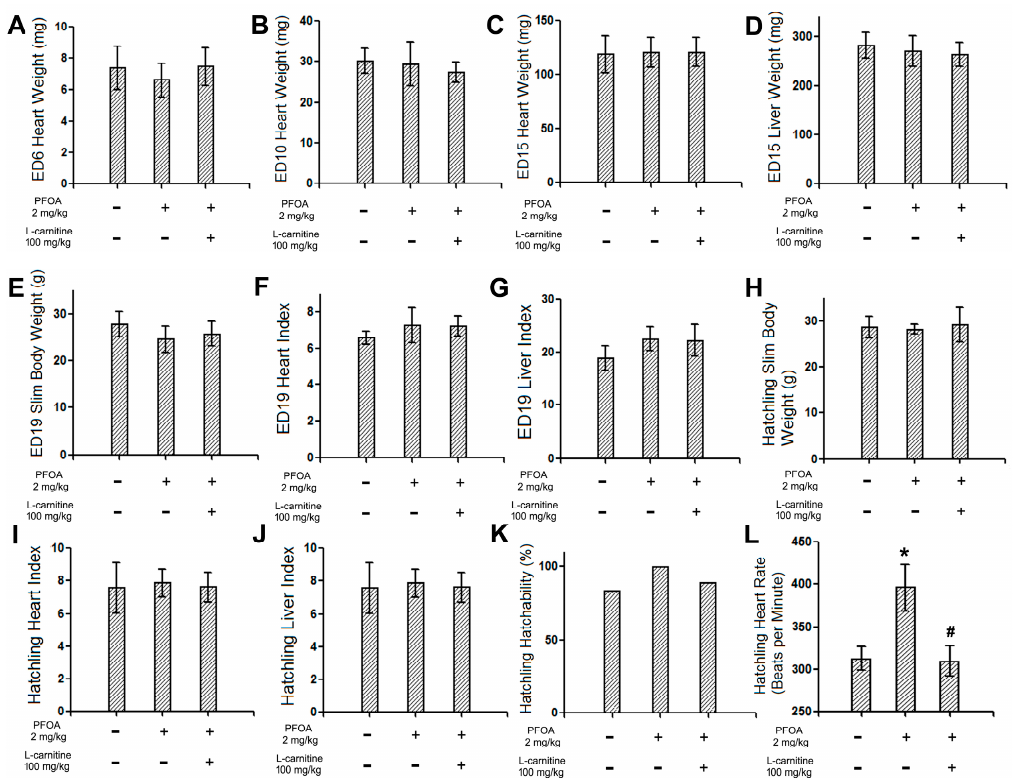
Figure 1. The general parameters of the embryonic day 6 (ED6), 10, 15, and 19 chicken embryos and hatchling chickens and the heart rates of the hatchling chickens. Fertile chicken eggs were air cell injected with vehicle, perfluorooctanoic acid (PFOA)2 mg/kg, or PFOA 2 mg/kg + L -carnitine 100 mg/kg, and then incubated to ED6, 10, 15, 19, or hatch. ( A ) heart weight of ED6 chicken embryos (